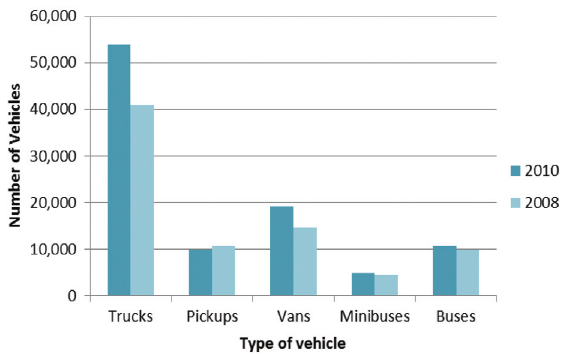
Fig. 3 - Distribution of diesel vehicles on the roads in 2008 and 2010 in the MAPA.